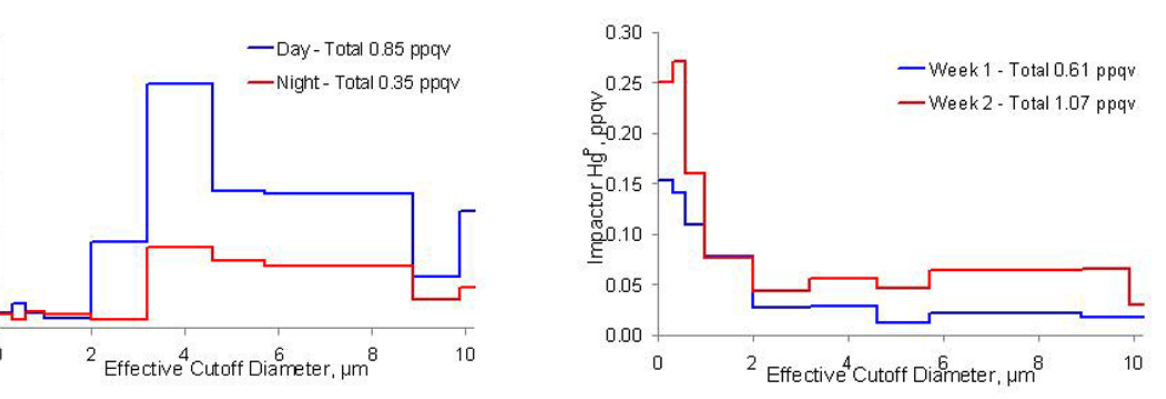
Fig. 4. Size Distribution of Hg P at Thompson Farm during winter 2010 showing the majority of Hg P in the fine particle range.